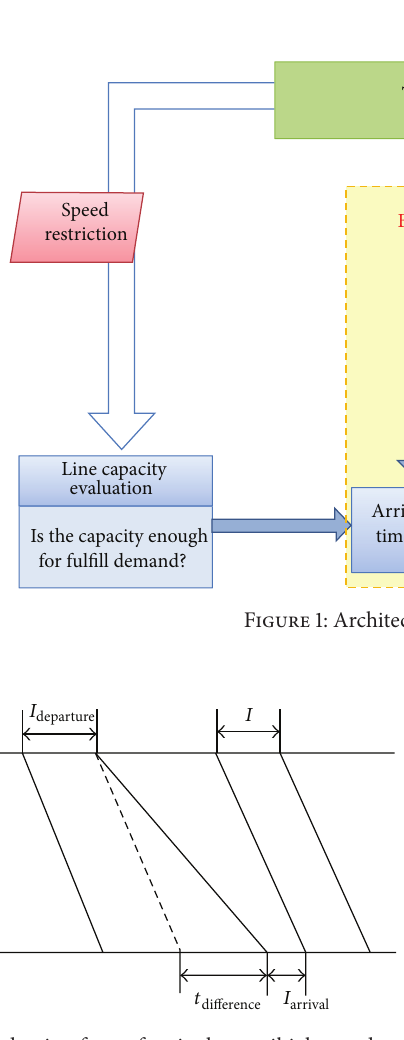
Figure 2: Deduction factor for single-quasihigh speed trains with- out stopovers with regard to high-speed trains without